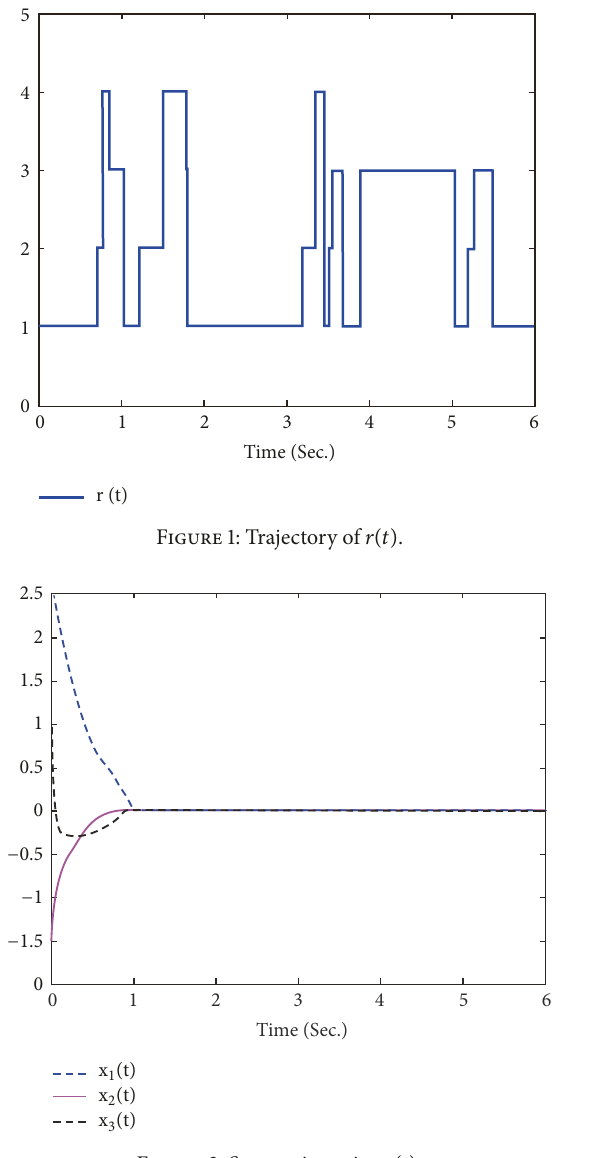
Figure 2: State trajectories 𝑥(𝑡) .